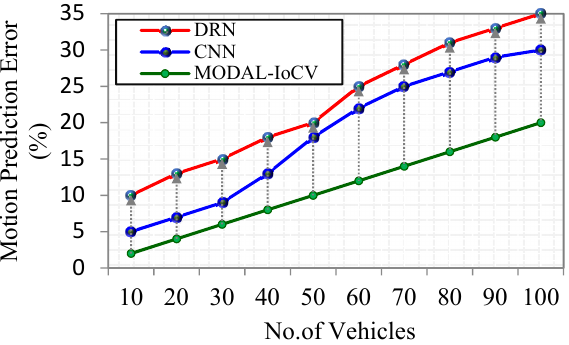
Figure 7. Number of vehicles vs. motion prediction error.